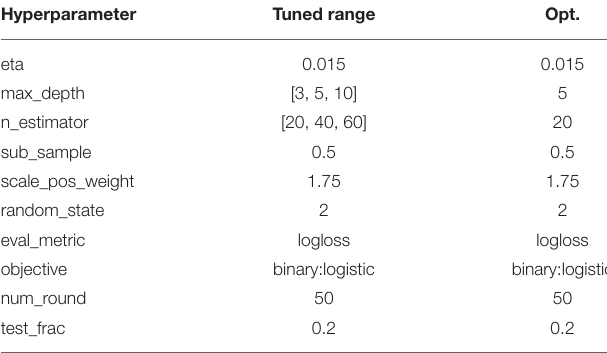
TABLE 5 | Hyperparameter setting for